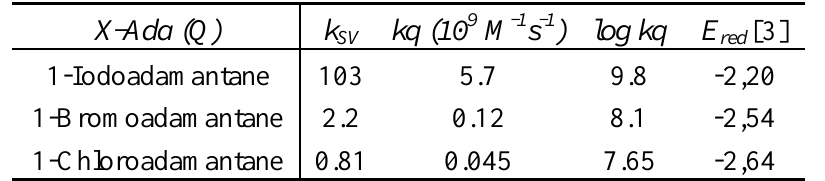
Table 1. Fluorescence quenching of the 2-naphtoxide ion by X-Ada.